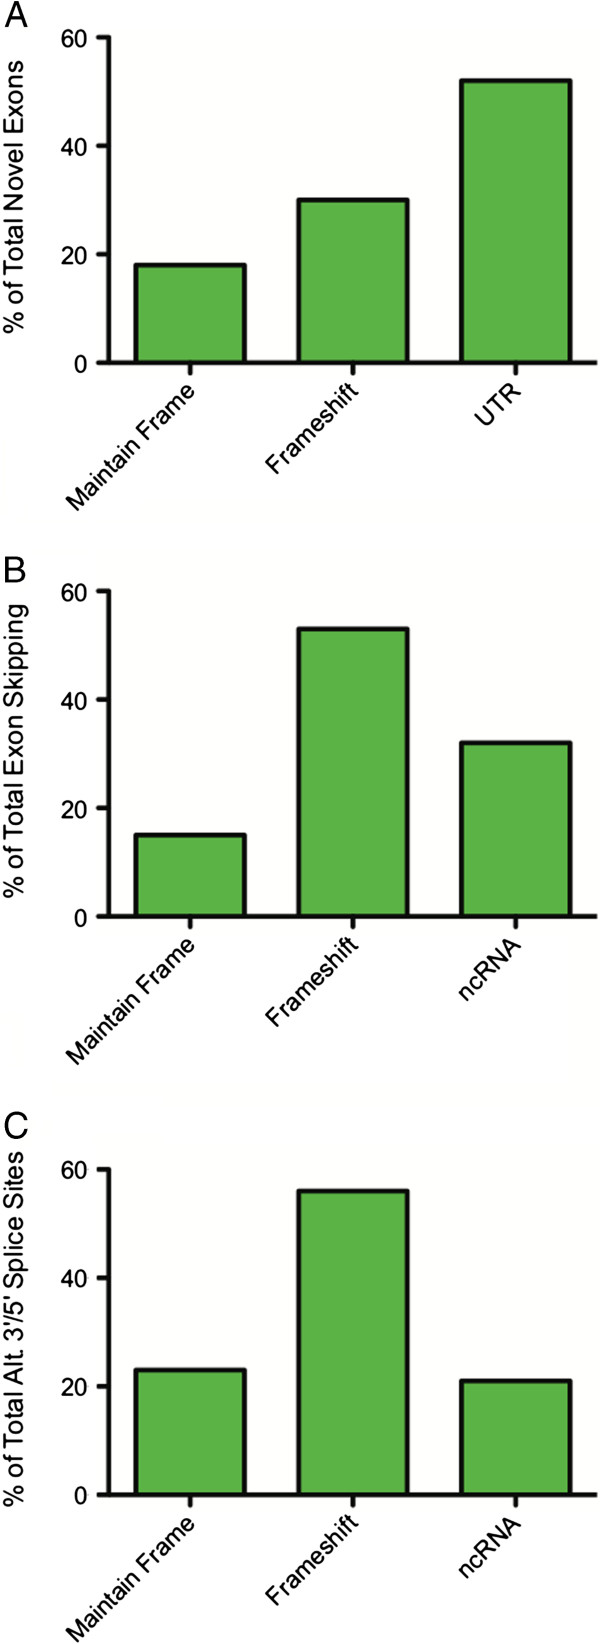
The effects of novel transcript features/splicing on reading frame. A) Of the 19,637 novel internal exons, 18% maintain an open reading frame (ORF), 30% result in a frameshift or contain a stop codon, and 52% are found within an untranslated region of the transcript. Of the 52% of novel exons that lie in an annotated UTR, 34% maintain an ORF (green bar) and 66% (gray bar) result in a frameshift or contain a stop codon. B) Of the 28,271 novel exon skipping events, 15% maintain an ORF, 53% result in a frameshift, and 32% are located in non-coding RNA (ncRNA). C) Of the 21,757 novel alternate 3′/5′ splice sites, 23% maintain an ORF, 56% result in a frameshift or contain a stop codon, and 21% are located in ncRNA.